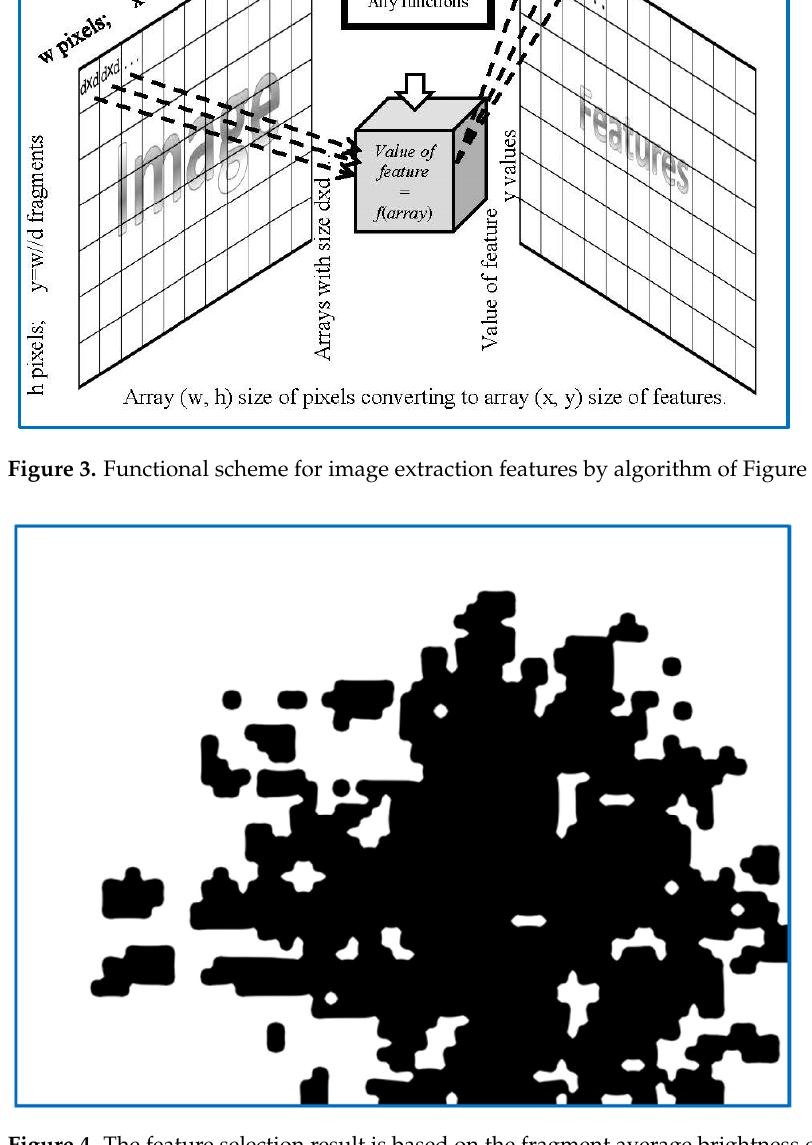
Figure 4. The feature selection result is based on the fragment average brightness or arithmetic mean of the brightness, 64 × 64 in size, with a step of 32